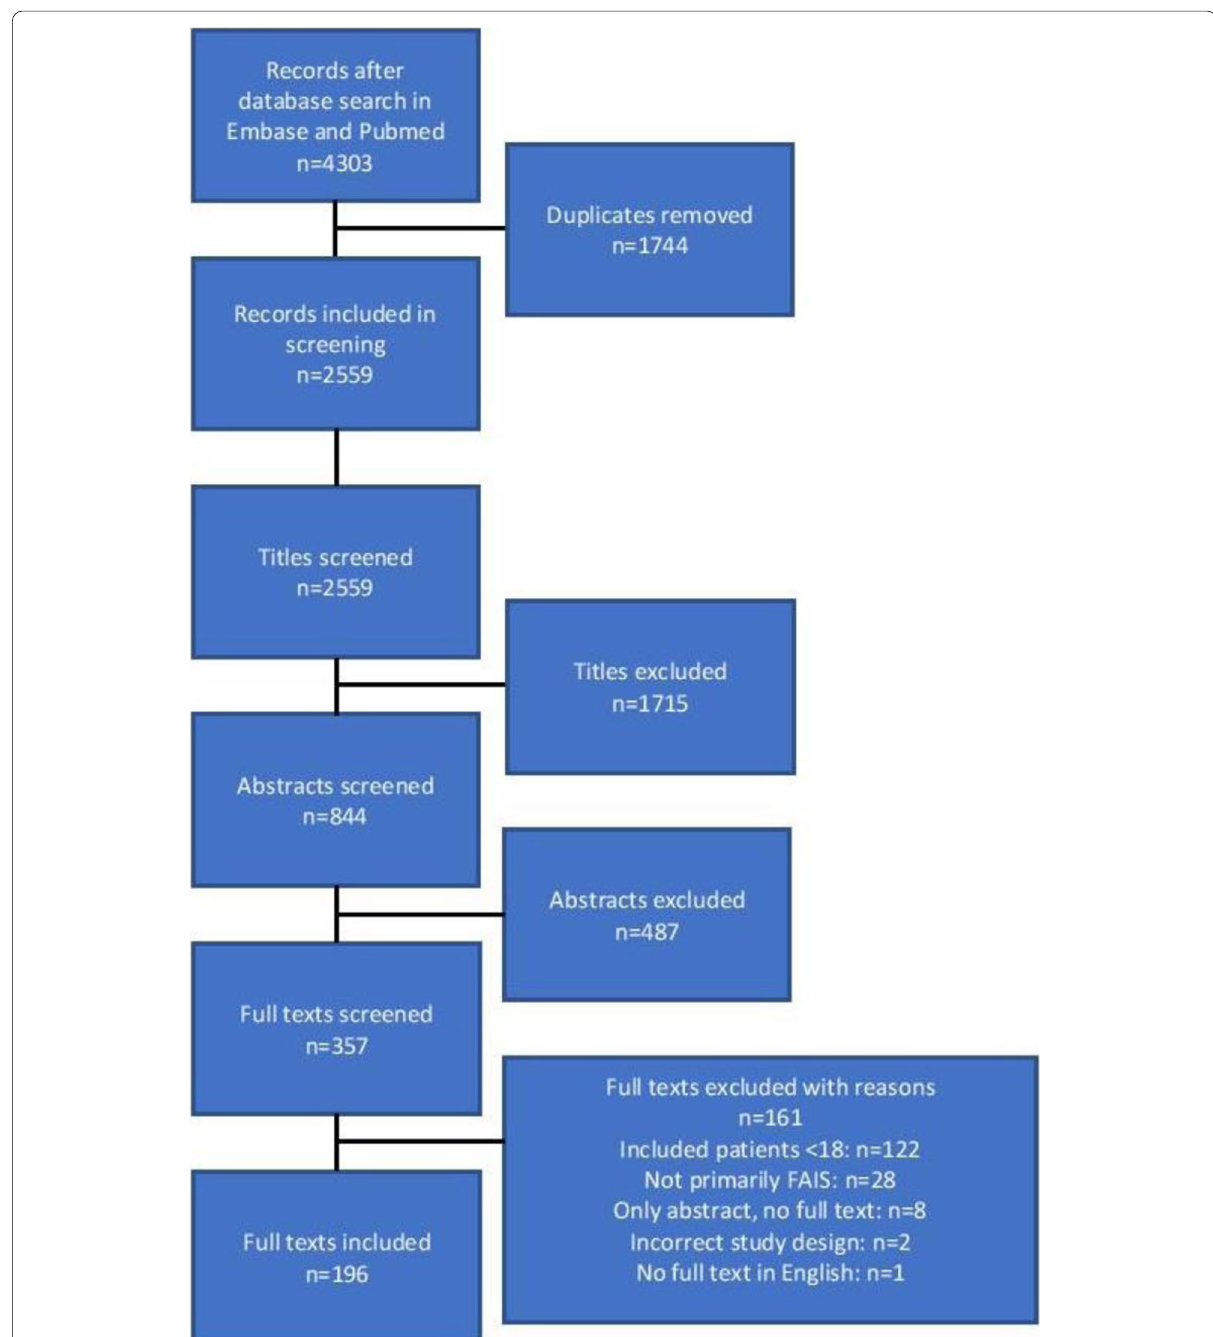
Fig. 1 Flow chart of the screening process and number of included